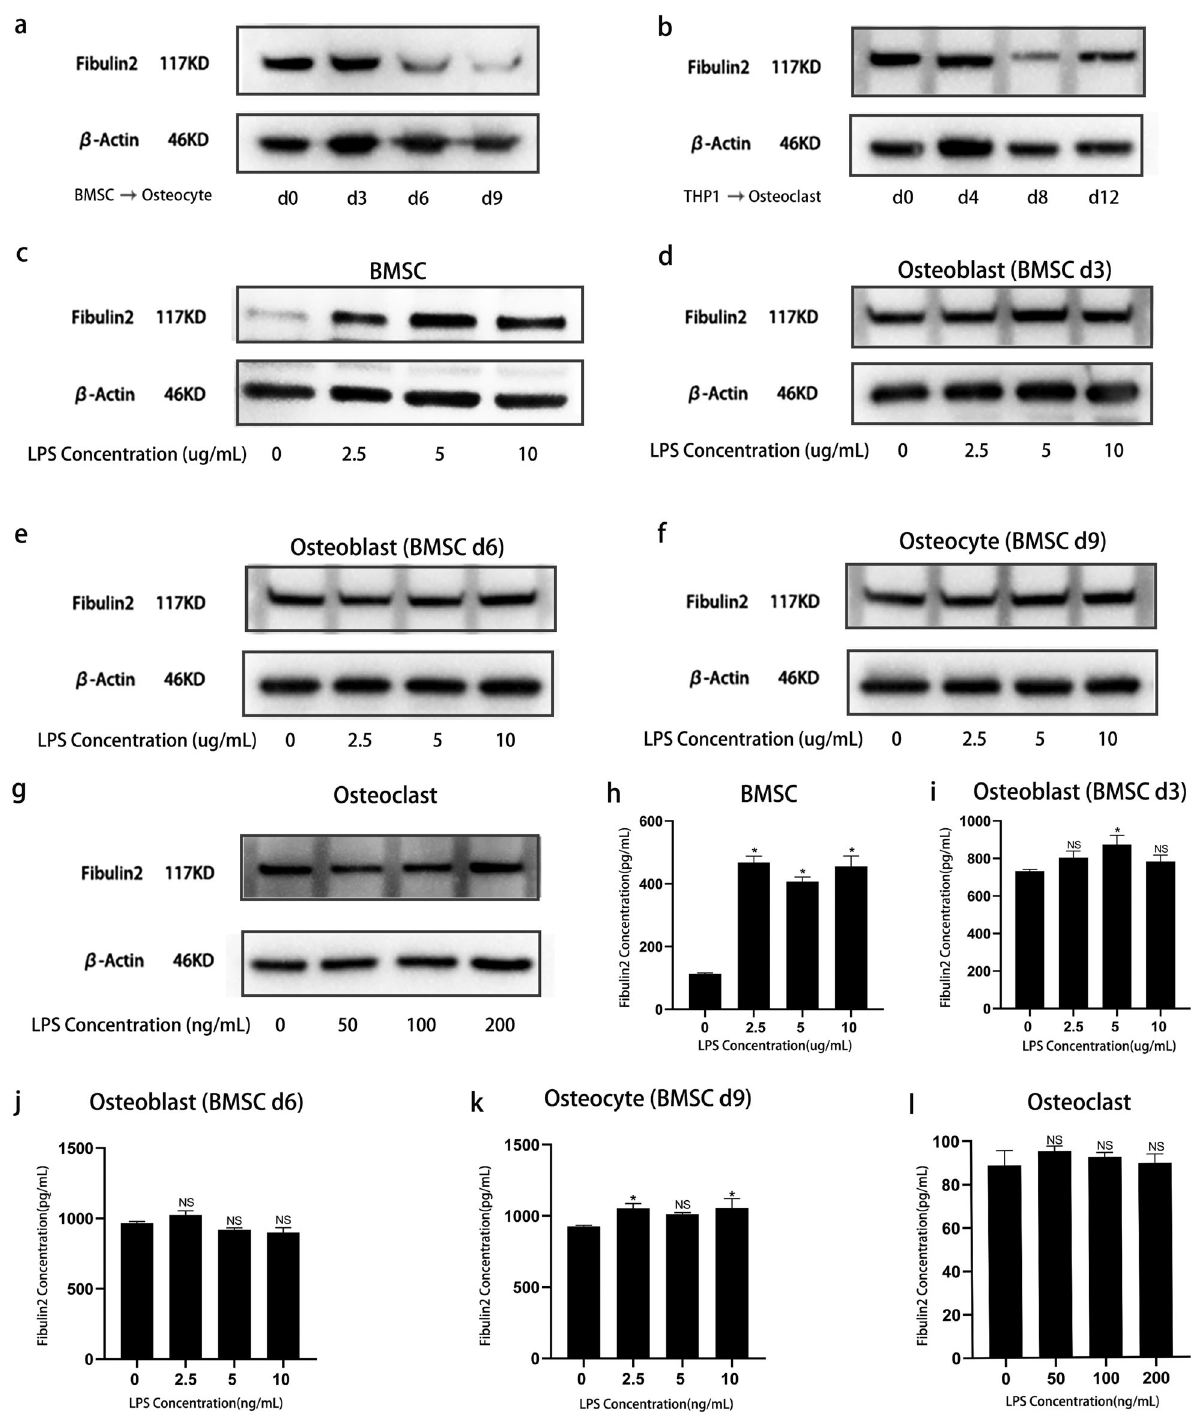
Fig. 3 Fibulin2 expression in different cells deep within the bone. a The differential expression of Fibulin2 in the BMSCs differentiated into osteocytes was detected by western blotting (WB). b The differential expression of Fibulin2 in the THP-1 cells differentiated into osteoclasts was detected by WB. The expression of Fibulin2 in BMSCs ( c ), osteoblasts ( d and e ), osteocytes ( f ), and osteoclasts ( g ) after stimulation with lipopolysaccharide (LPS) for 24 h was detected by WB. The expression of Fibulin2 in BMSCs ( h ), osteoblasts ( i and j ), osteocytes ( k ), and osteoclasts ( l ) after stimulation with LPS for 24 h was detected by ELISAs. Osteoblasts were derived from BMSCs after induction of osteogenic differentiation for 3 or 6 days; osteocytes were derived from BMSCs after osteogenic differentiation for 9 days; and osteoclasts were derived from THP-1 cells after osteoclast differentiation for 12